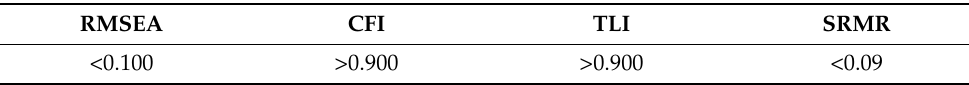
Table 3. Acceptable fit indices for the CFA and the measurement model. RMSEA CFI TLI